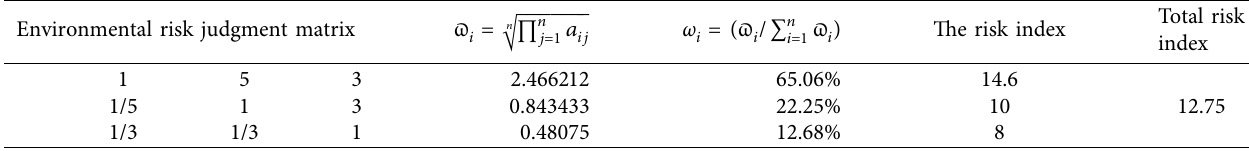
Table 41: Environmental risk judgment matrix.